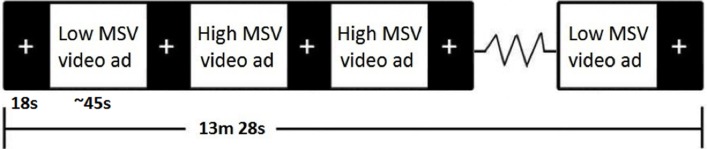
Design of the video task.The actual task displays 16 video messages (8 high MSV and 8 low MSV) in pseudorandom order (the order presented above is one possible organization).